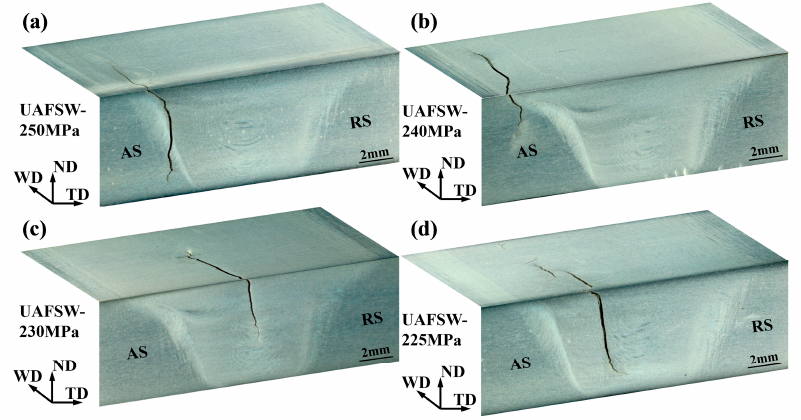
Figure 8. Fracture locations of the FSW fatigue specimens at different maximum stresses of 250 ( a ); 240 ( b ); 230 ( c ); 220 ( d ) and 210 MPa ( e ). Materials 2020 , 13 , x